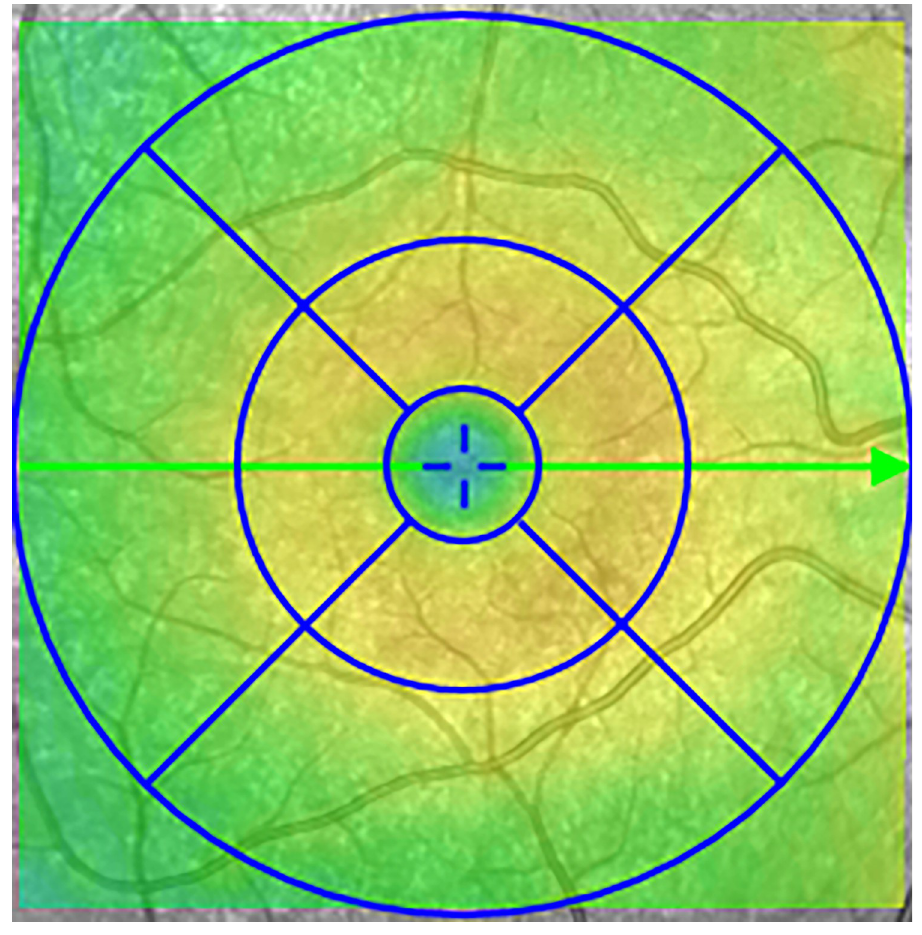
Fig 1. ETDRS grid. ETDRS grid: Fovea, in the middle of the circle with a diameter of 1mm; pericentral ring, area around the fovea with diameter of 3mm; peripheral ring, outer ring of the circle with a diameter of 6mm. Abbreviation: ETDRS = Early Treatment Diabetic Retinopathy